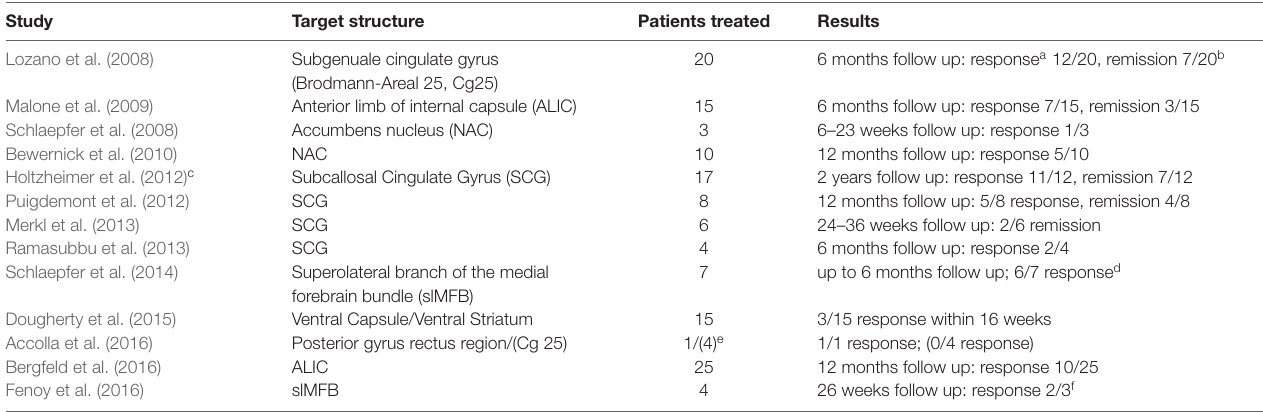
TABLE 1 | Previous studies on deep brain stimulation (DBS) for major depressive disorder (MDD) with three or more participants (Original table).